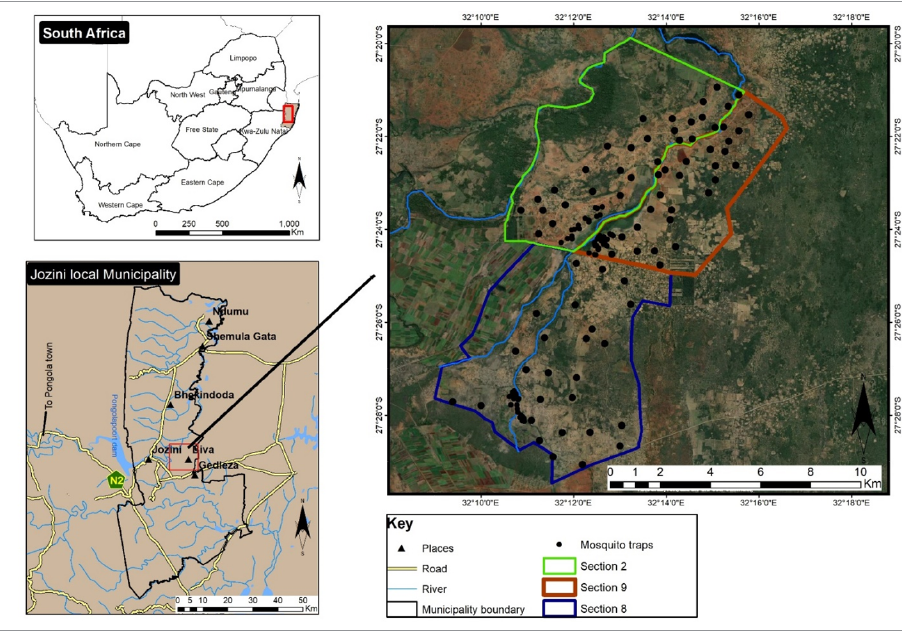
Figure 1: Map of Jozini municipality, northern KwaZulu–Natal Province, South Africa, showing sampling points from which anopheline mosquitoes were collected monthly between November 2019 and April